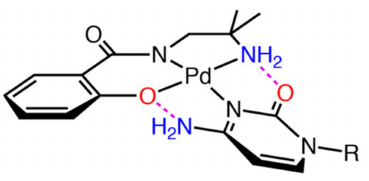
Figure 7. Chemical structure of Pd-C (R indicates the ribose moiety). Hydrogen-bond donor and acceptor are shown in blue and red, respectively. Dashed lines in magenta indicate intramolecular hydrogen bonds.